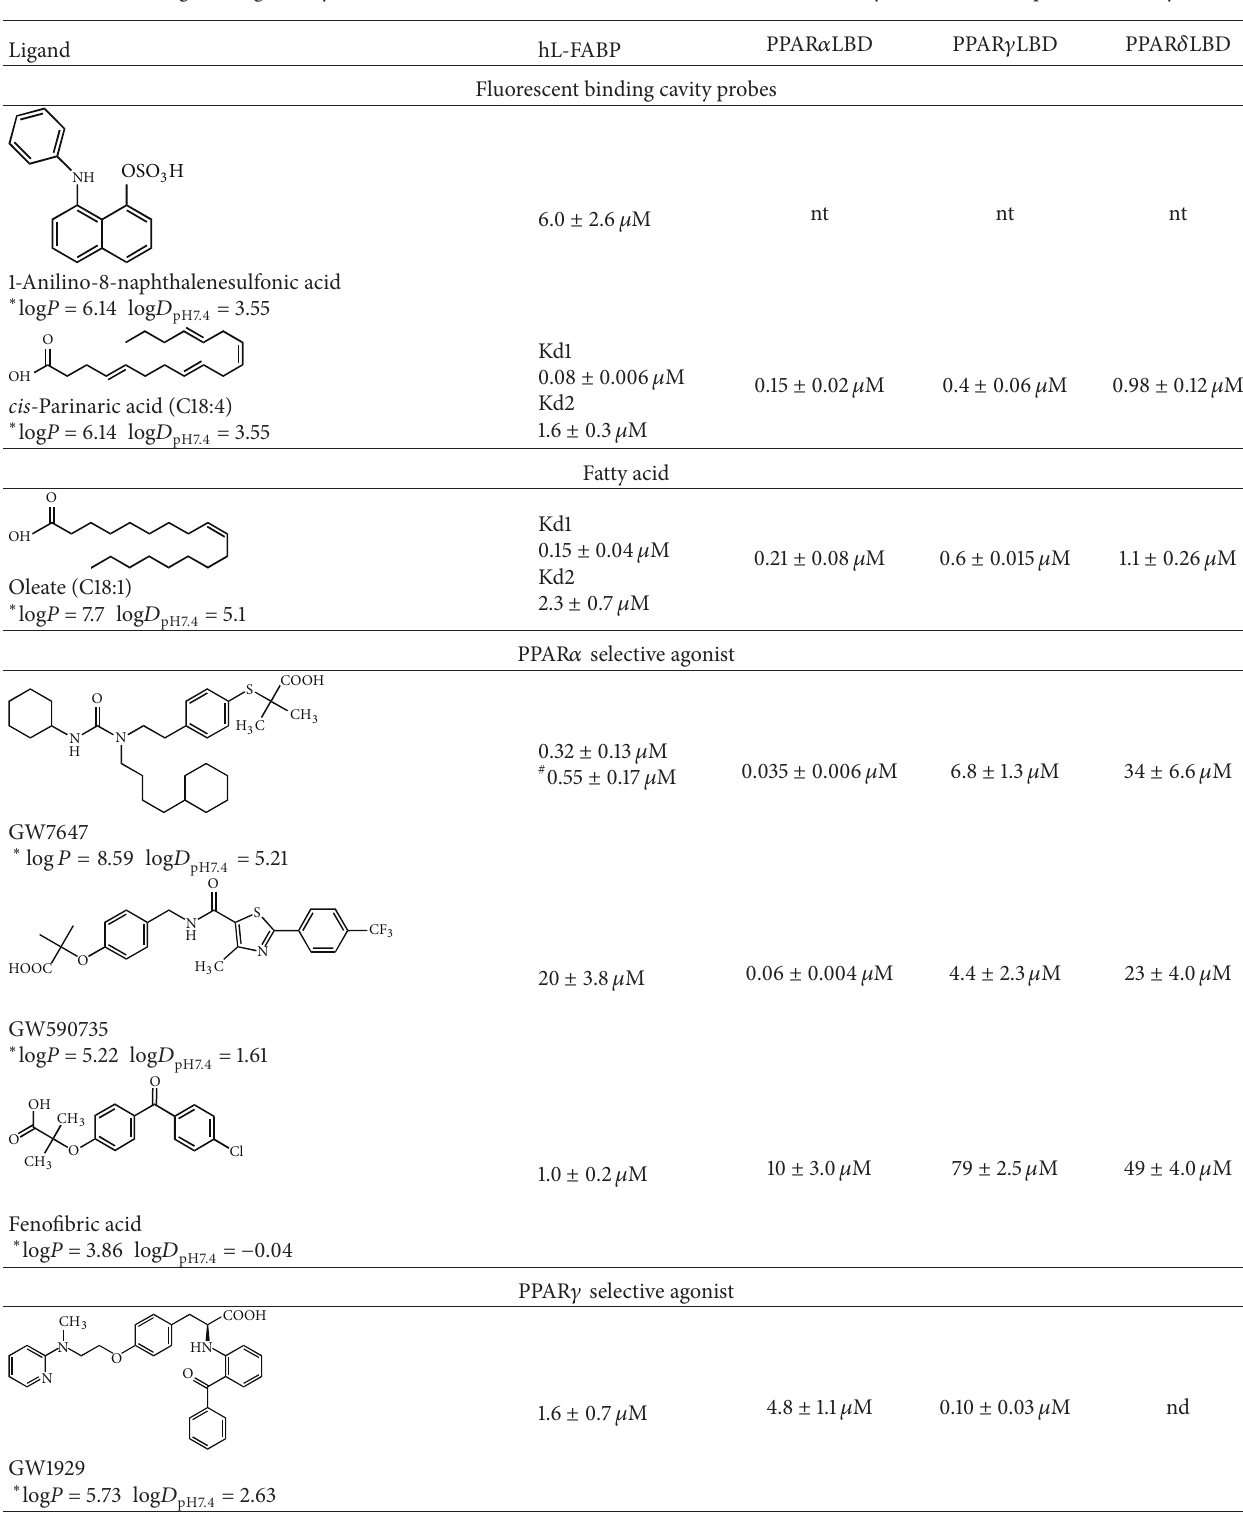
Table 1: Drug binding affinity constants for human L-FABP and PPAR LBDs determined by fluorometric displacement assays.